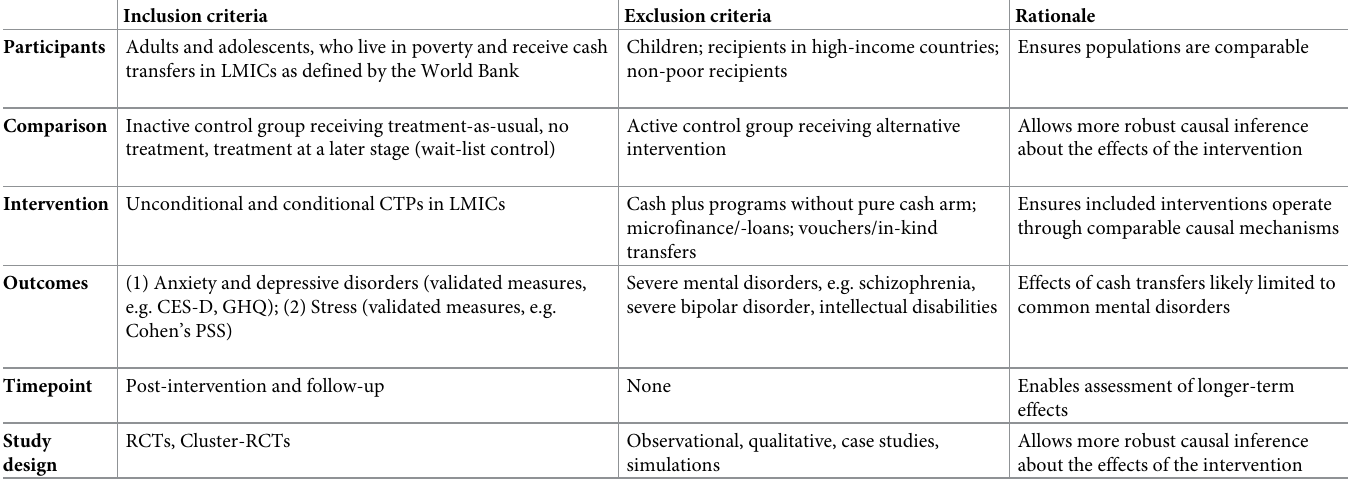
Table 1. Overview of inclusion and exclusion